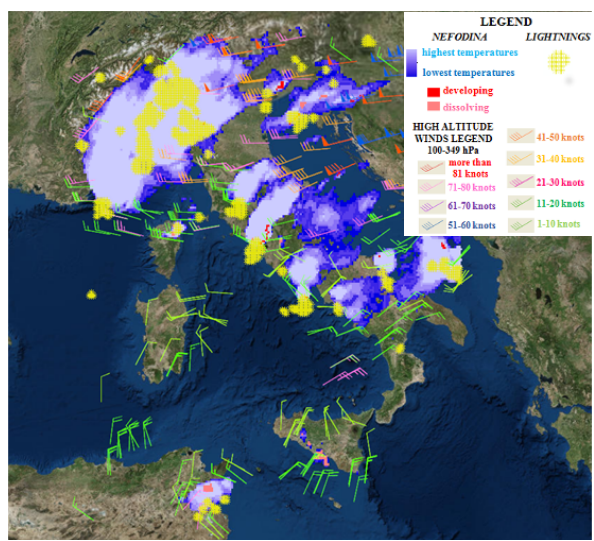
Figure 5. Overlapping of strong winds, convective clouds and light- ning occurring 14 June 2014, 17:00UTC.